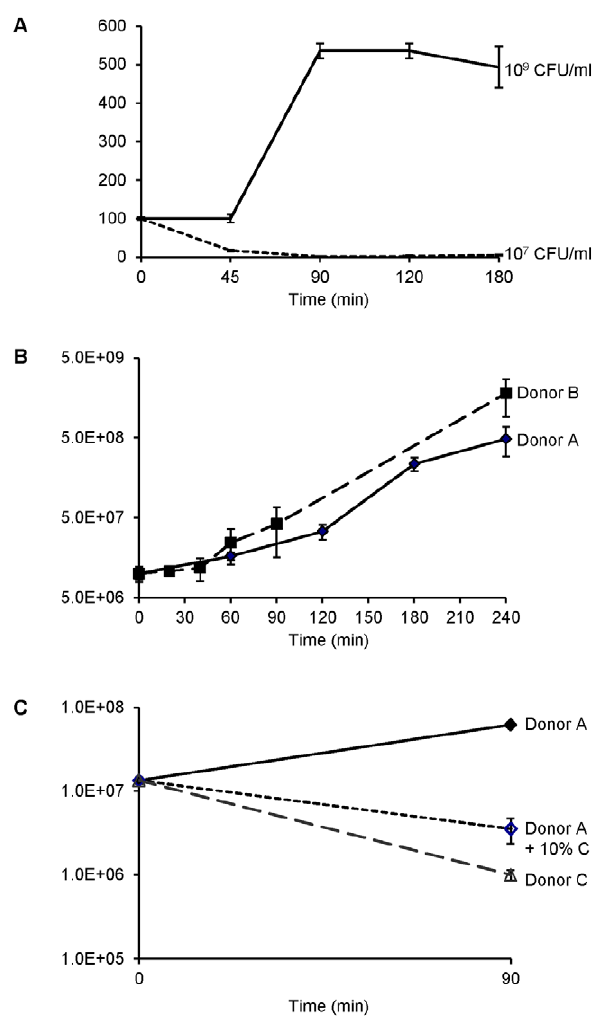
Figure 1. Growth of meningococci (strain MC58) in whole human blood. Meningococcal growth is shown by CFU obtained at time points after initial inoculation. Error bars indicate SEM of biological replicates. ( A ) Growth of meningococci in donor C blood expressed as percent of initial inoculum, 10 7 (dashed line) or 10 9 (solid line) CFU per ml of blood. ( B ) Growth of meningococci in donor A (solid line) and B (dashed line) blood. ( C ) Growth of meningococci in donor A (solid line) and C (dashed line) blood, and donor A blood ‘‘doped’’ with 10% of donor C plasma (dotted line).